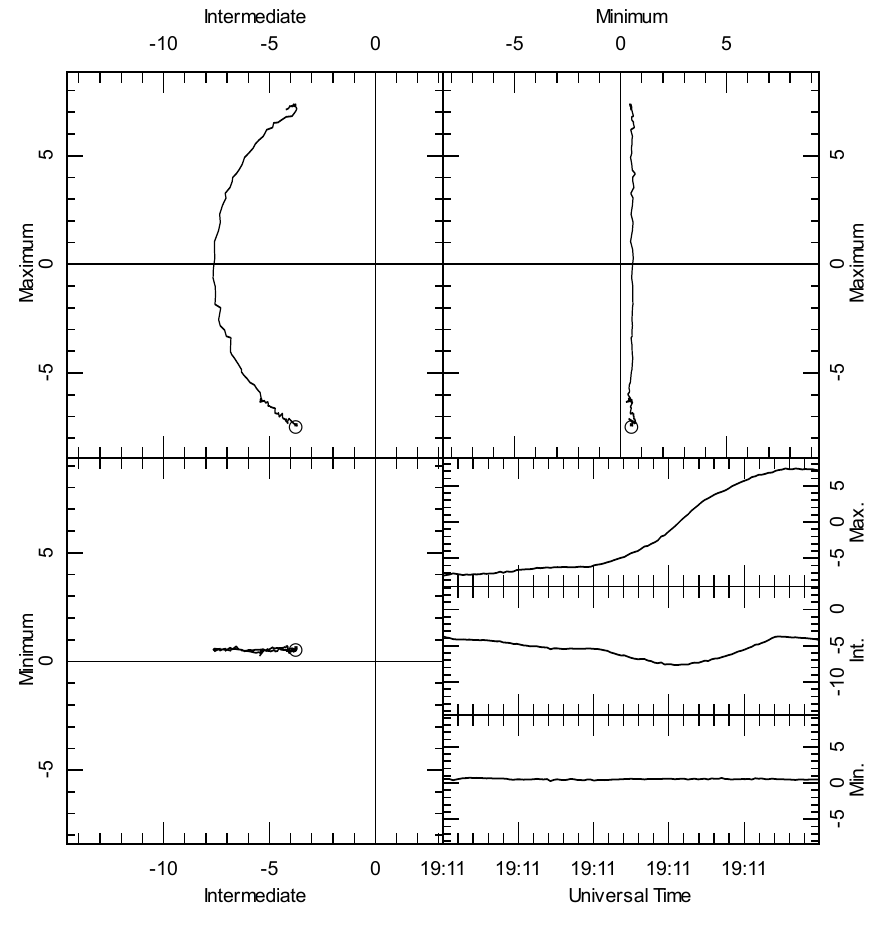
Fig. 5. Cluster 1 event in Fig. 1: Hodogram for the rapid field rotation alone. Resolution is 22.4 samples/s. Time axis in lower right panel spans 5s from 19:11:32 to 19:11:37. The eigenvalue ratio is λ 2 /λ 1 = 230; further details from the MVAB calculation are given in Table